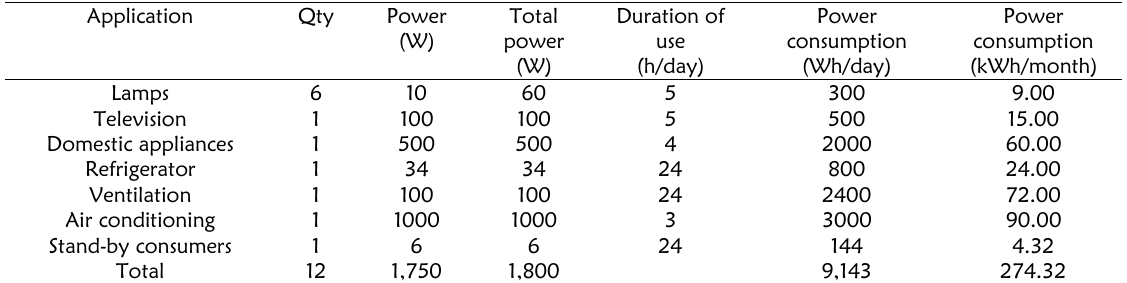
Table 3: Suggested electrical usage in eco-tourism